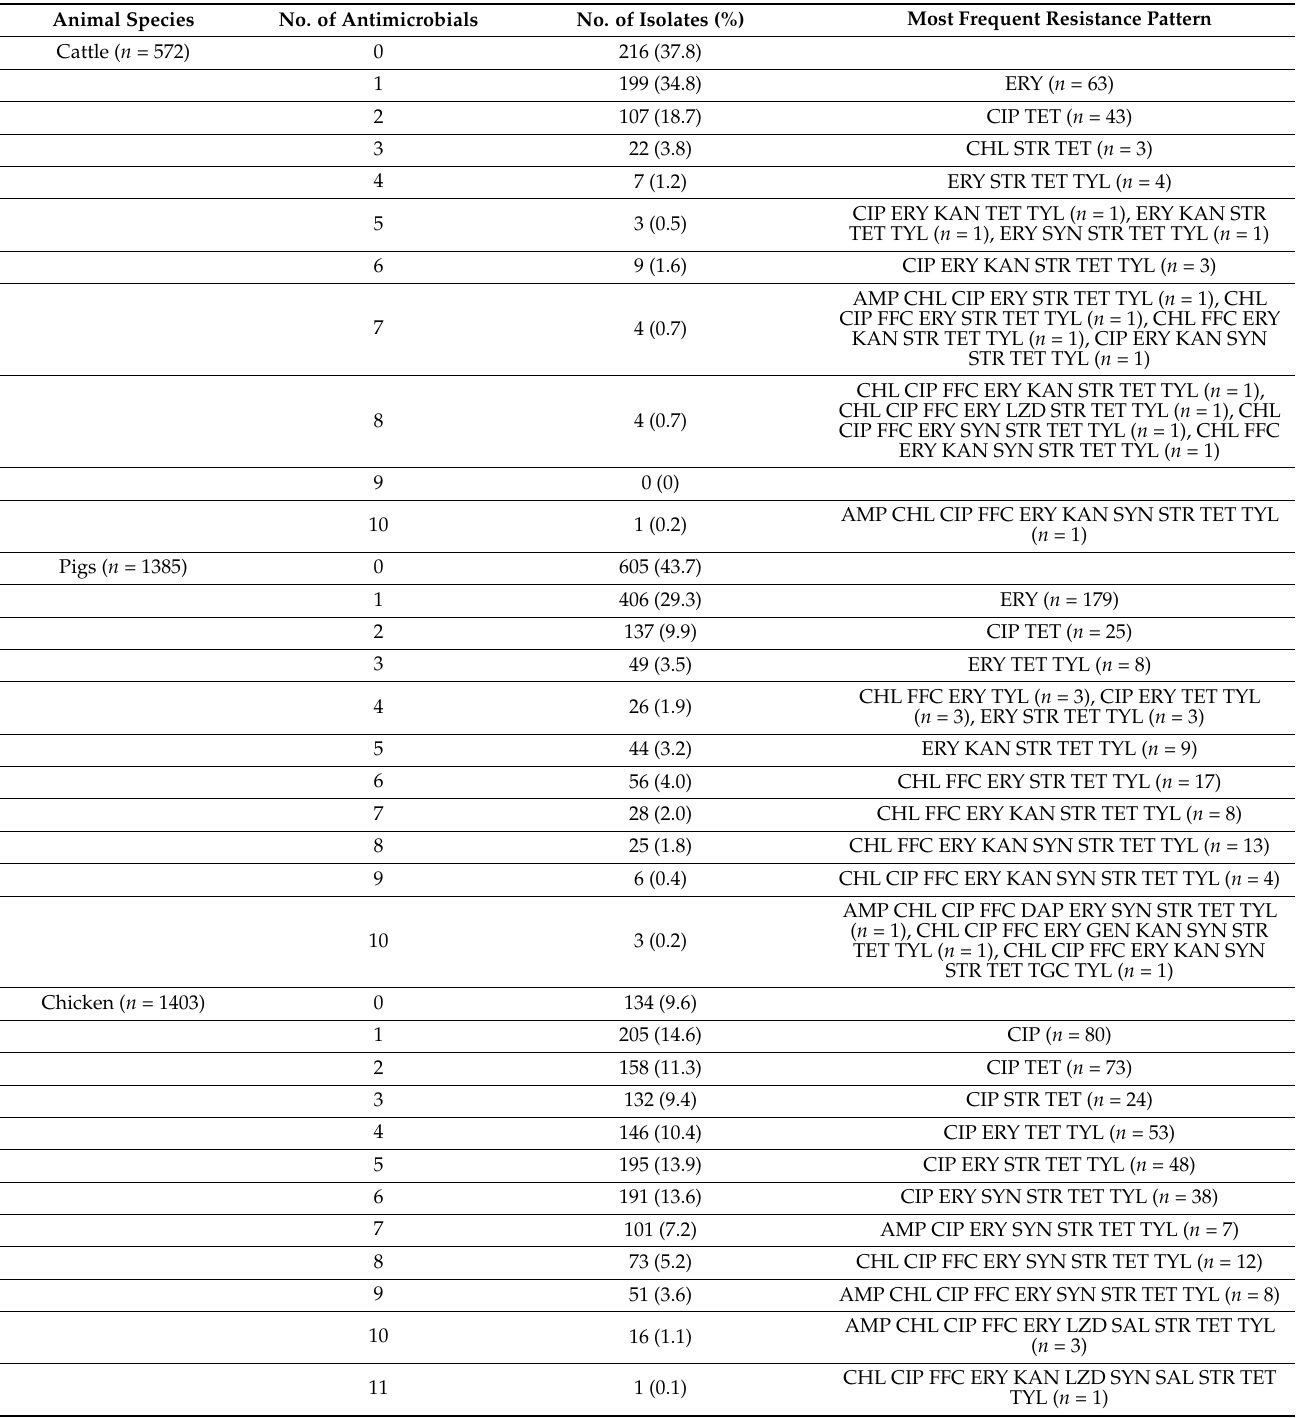
Table 2. Frequent resistance patterns in E. faecium isolates ( n = 3360) recovered from cattle, pigs, and chickens between 2010 and 2019 in